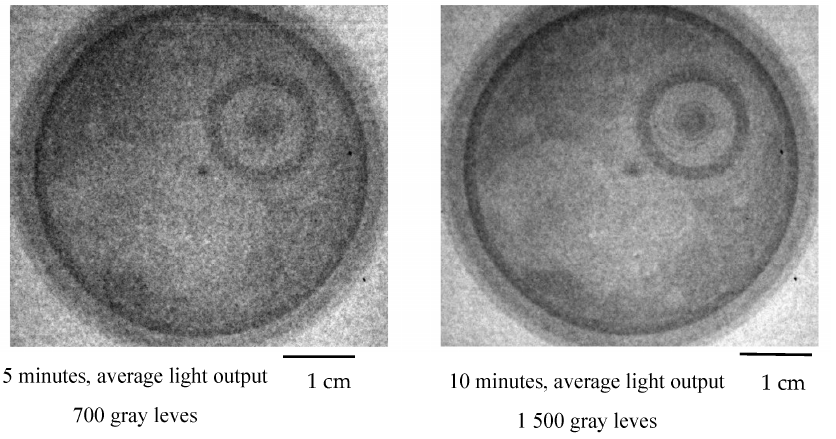
Figure 7. Neutron radiograph of a pocket watch at different exposure times (L/D = 50). Grayscales are stretched for optimal display, and are not the same as Figure 6.